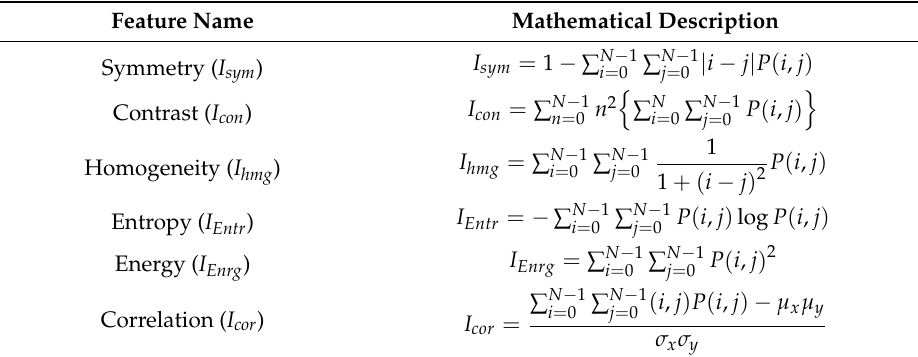
Table 3. Mathematical description of Haralick